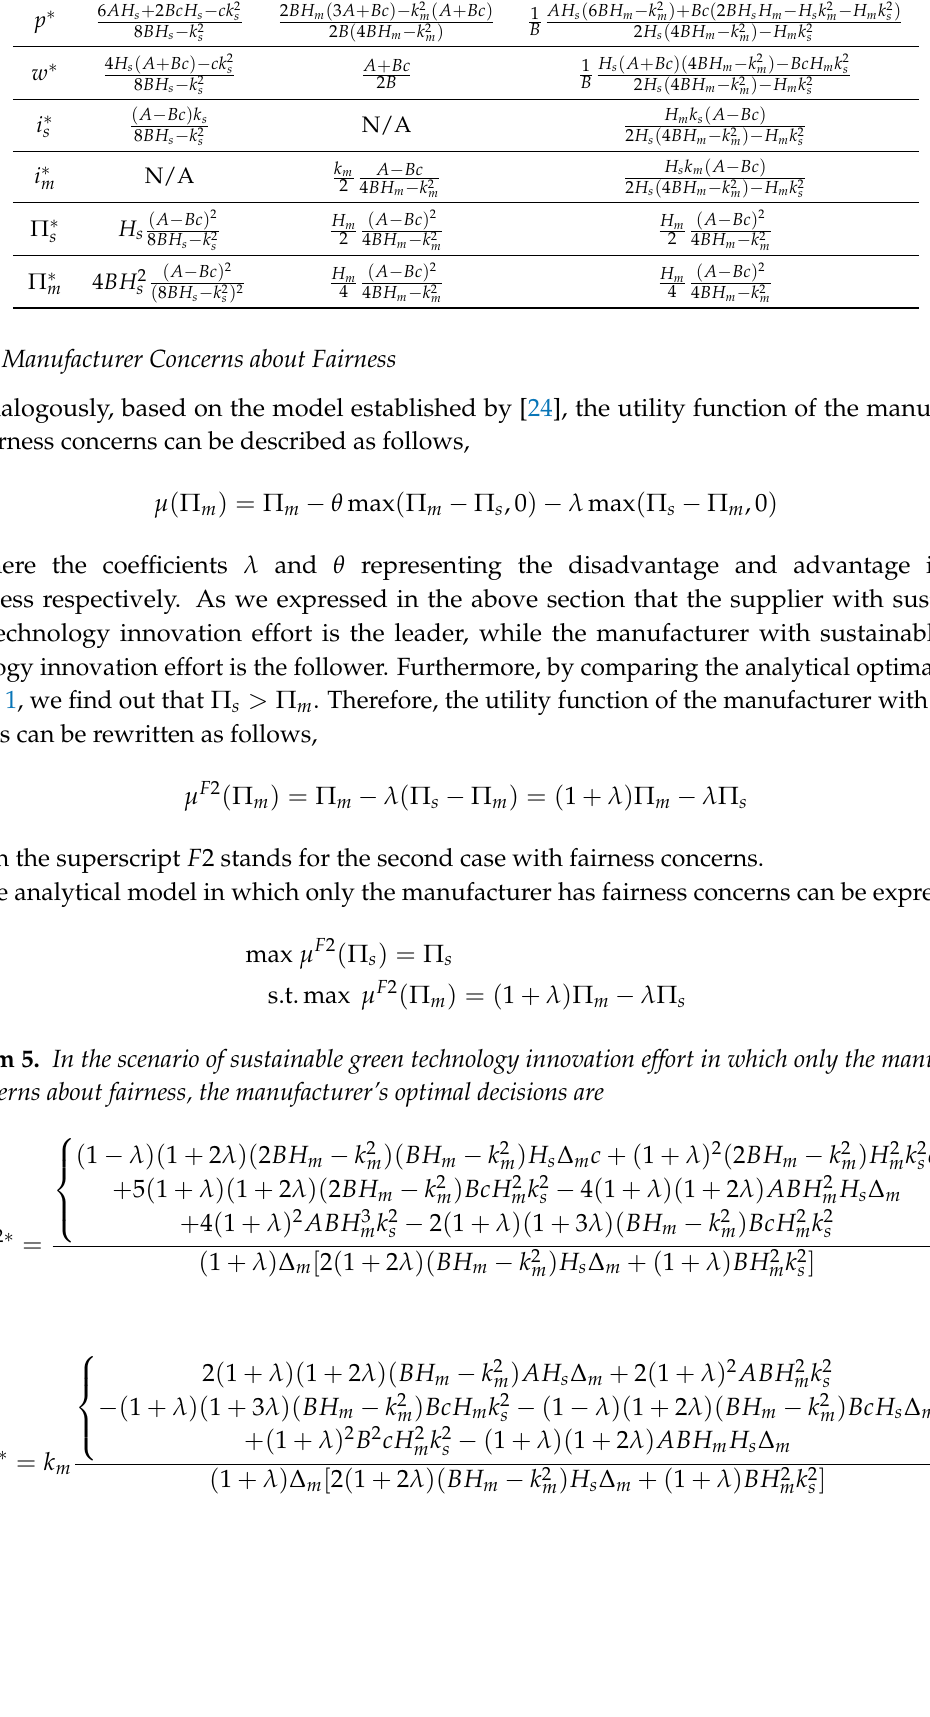
Table 1. Optimal decision results comparison (The benchmarking model of sustainable green technology innovation efforts without fairness concerns by the supplier, by the manufacturer, and by both of them respectively). Only Supplier Only Manufacturer Both of